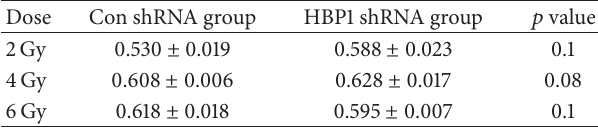
Table 2: Comparison of cell viability of Con shRNA group and HBP1 shRNA group at 48 h after different dose gradient